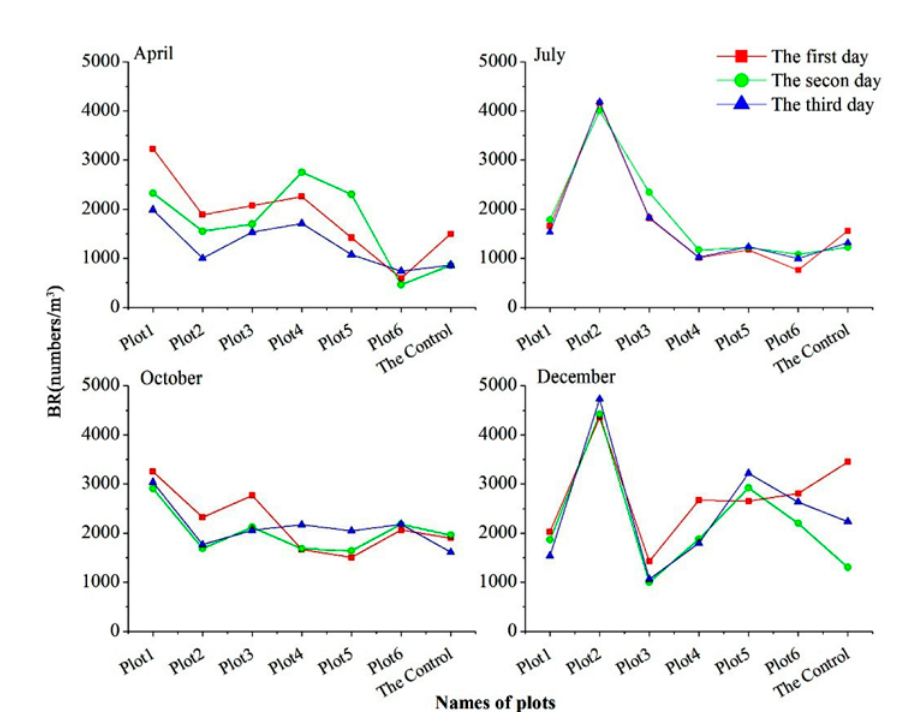
Fig. 13. Air BR changes of green belts over 3